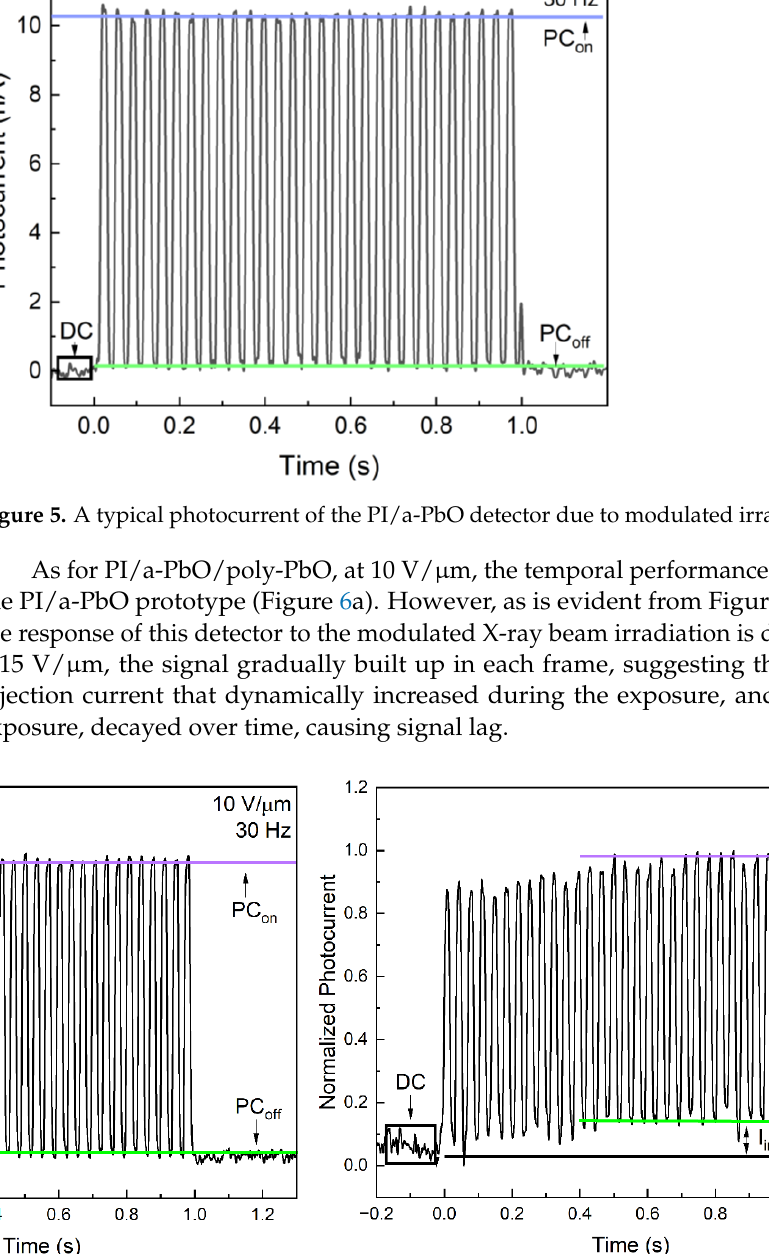
( b ) Figure 7. Signal lag as a function of ( a ) electric field for 30 Hz modulation frequency and ( b ) varying frequency for an applied electric field of 10 V/µm in a-PbO, bilayer PbO and a-Se, and 2 V/µm for poly-PbO [18,22,34,40]. Error bars have been added for the a-PbO/poly-PbO sample that was eval- uated for this work. Data points are connected with dashed lines as a guide for the eye.